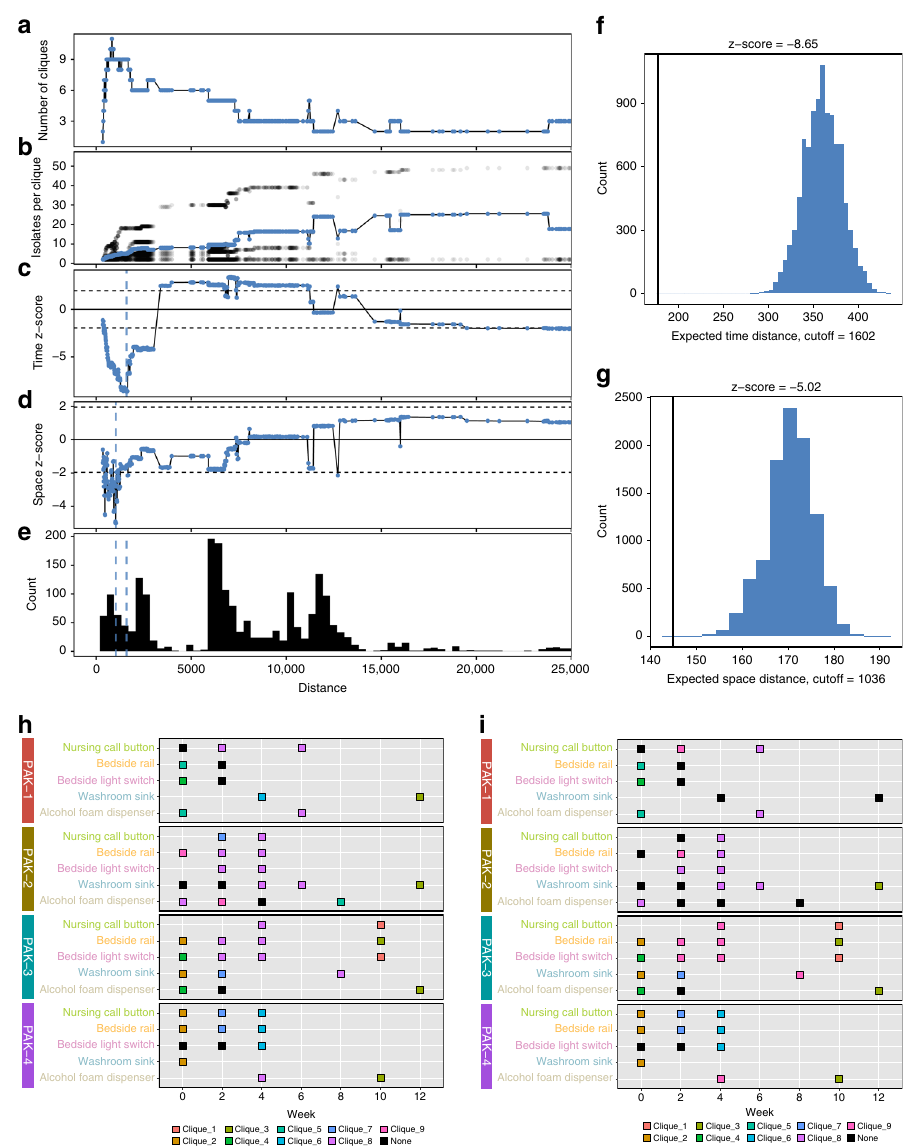
Fig. 5 A. baumannii optimal pairwise variant distance cliques identi fi ed by spatial and temporal data. A. baumannii isolate clique groupings with the lowest observed spatial and temporal distances compared to the expected distribution. Panels a – e give information on the clique groupings for each unique variant distance cutoff ( x -axis) starting at the minimum variant distance and extending until the minimum variant distance between two isolates from different lineages. Panel a shows the number of completely connected cliques identi fi ed at the current cutoff value. Panel b shows the number of isolates per clique, with the black dots showing each individual clique and the blue points showing the average per clique. Panels c and d show the deviation ( z -score given as blue points) of the observed temporal ( c ) or spatial ( d ) distance compared to the expected distribution. The dotted lines show the upper and lower signi fi cance bounds. e Histogram of the number of pairwise comparisons in different variant distance cutoff ranges. Blue dashed lines show the minimum z - score cutoffs for the temporal and spatial distances given in c and d . Panels f and g show the observed distance value vs the expected distribution for the minimum z -score values identi fi ed in c and d for temporal ( f ) and spatial ( g ) distance. The black vertical line is the observed distance and blue fi lled histogram is the expected distribution. Panels h and i show the cliques identi fi ed at the minimum z -score cutoffs for temporal ( h ) and spatial ( i ) distance measurements. Source data for all panels are provided in the source data fi